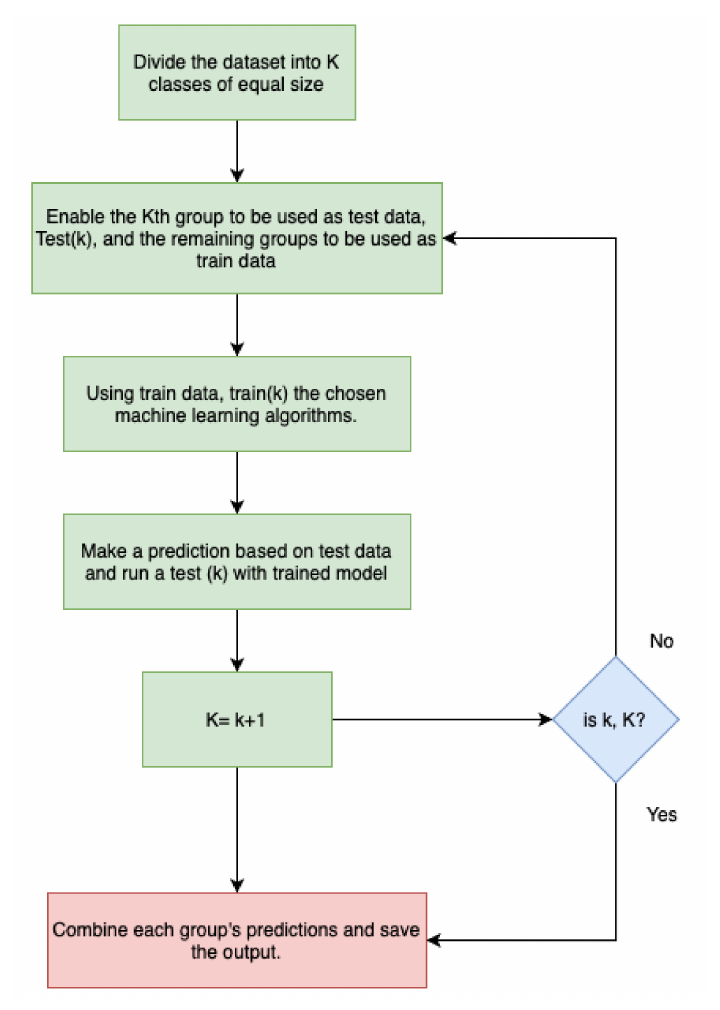
Figure 1. Schematic of K-fold